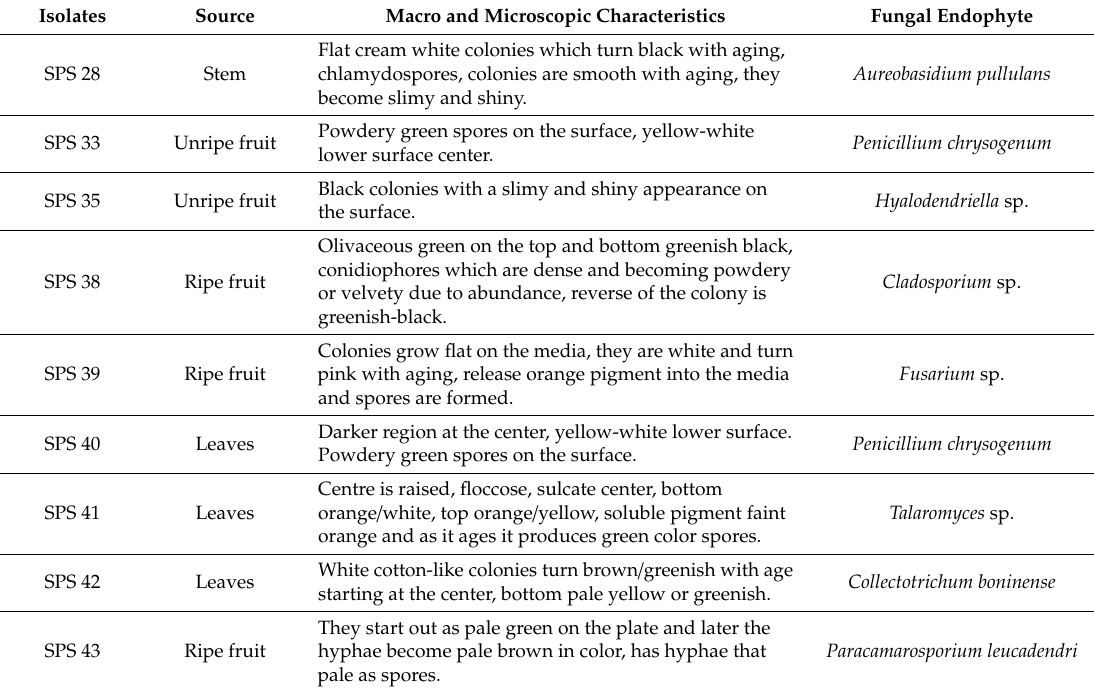
Table 1. Morphological observations and characteristics of the fungal